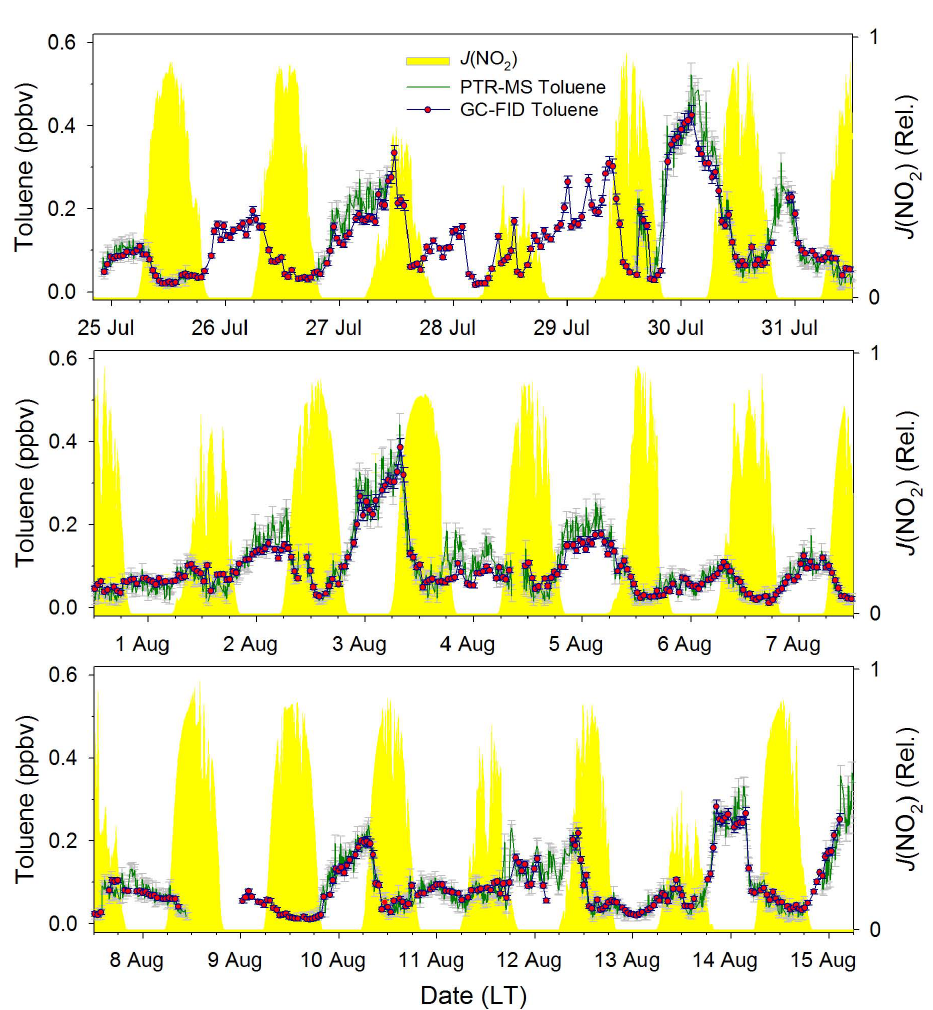
Fig. 6. Time series of toluene measured by GC-FID and PTR-MS during the period between 24 July, 22:00 LT and 15 August, 06:00 LT. Values of J (NO 2 ) are show as in Fig. 5. Errors in the GC-FID and PTR-MS data are the greater of the 1 σ measurement precision or